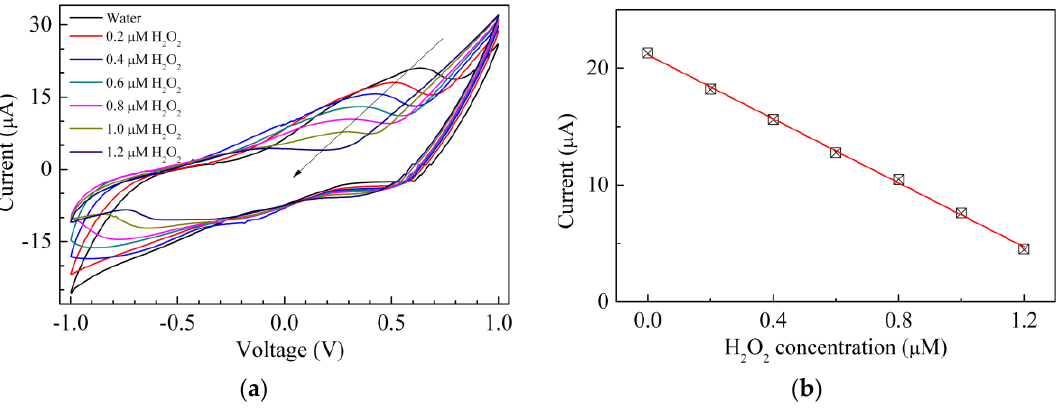
Figure 7. ( a ) Current-voltage loop of the Au/chitosan:CuOx/chitosan/Au cell, measured in water, and in the presence of hydrogen peroxide at different concentrations; ( b ) Intensity of the forward current peak intensities of Figure 7a, plotted against the H 2 O 2 concentration.